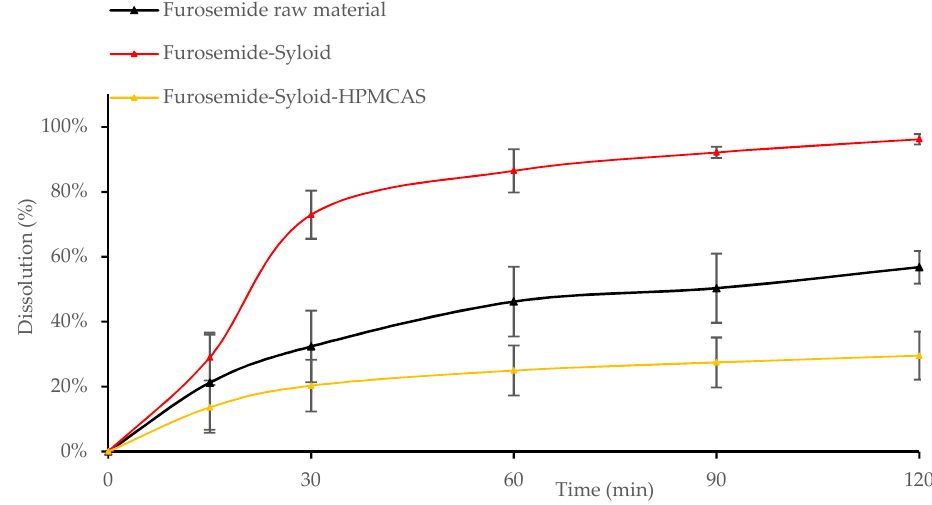
Figure 11. Release profiles of Furosemide raw material, Furosemide-Syloid, Furosemide-Syloid-HPMCAS at drug load of 300% surface coverage. Testing conditions: medium pH 3 + 0.25% SLS, 900 mL, USP apparatus 1, 100 rpm.